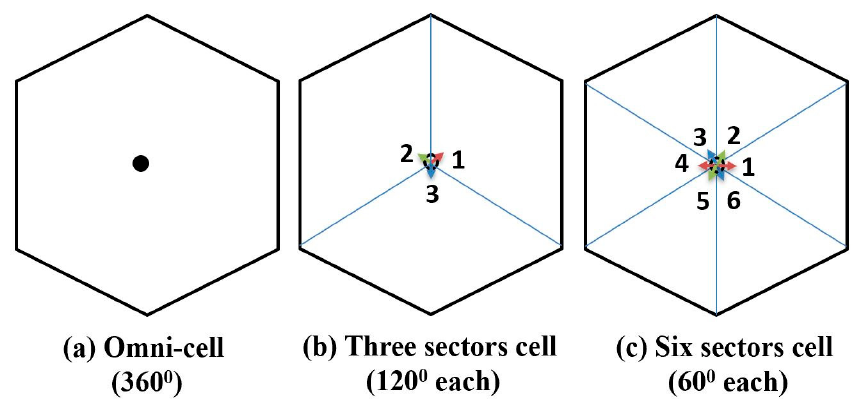
Figure 20. Cell sectorization with directional antennas.